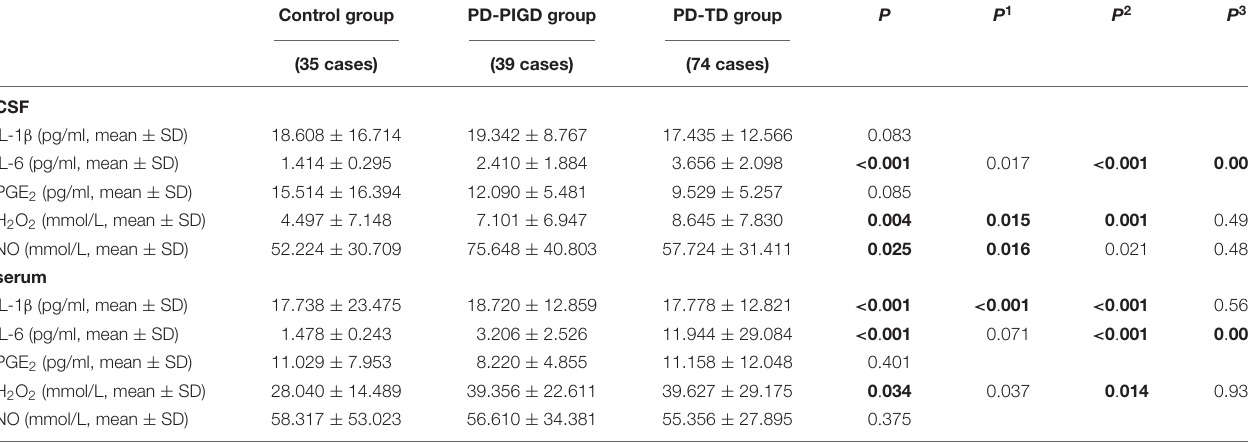
TABLE 3 | The levels of inflammatory factors in CSF and serum from the control, PD-PIGD and PD-TD groups. Control group PD-PIGD group PD-TD group P P